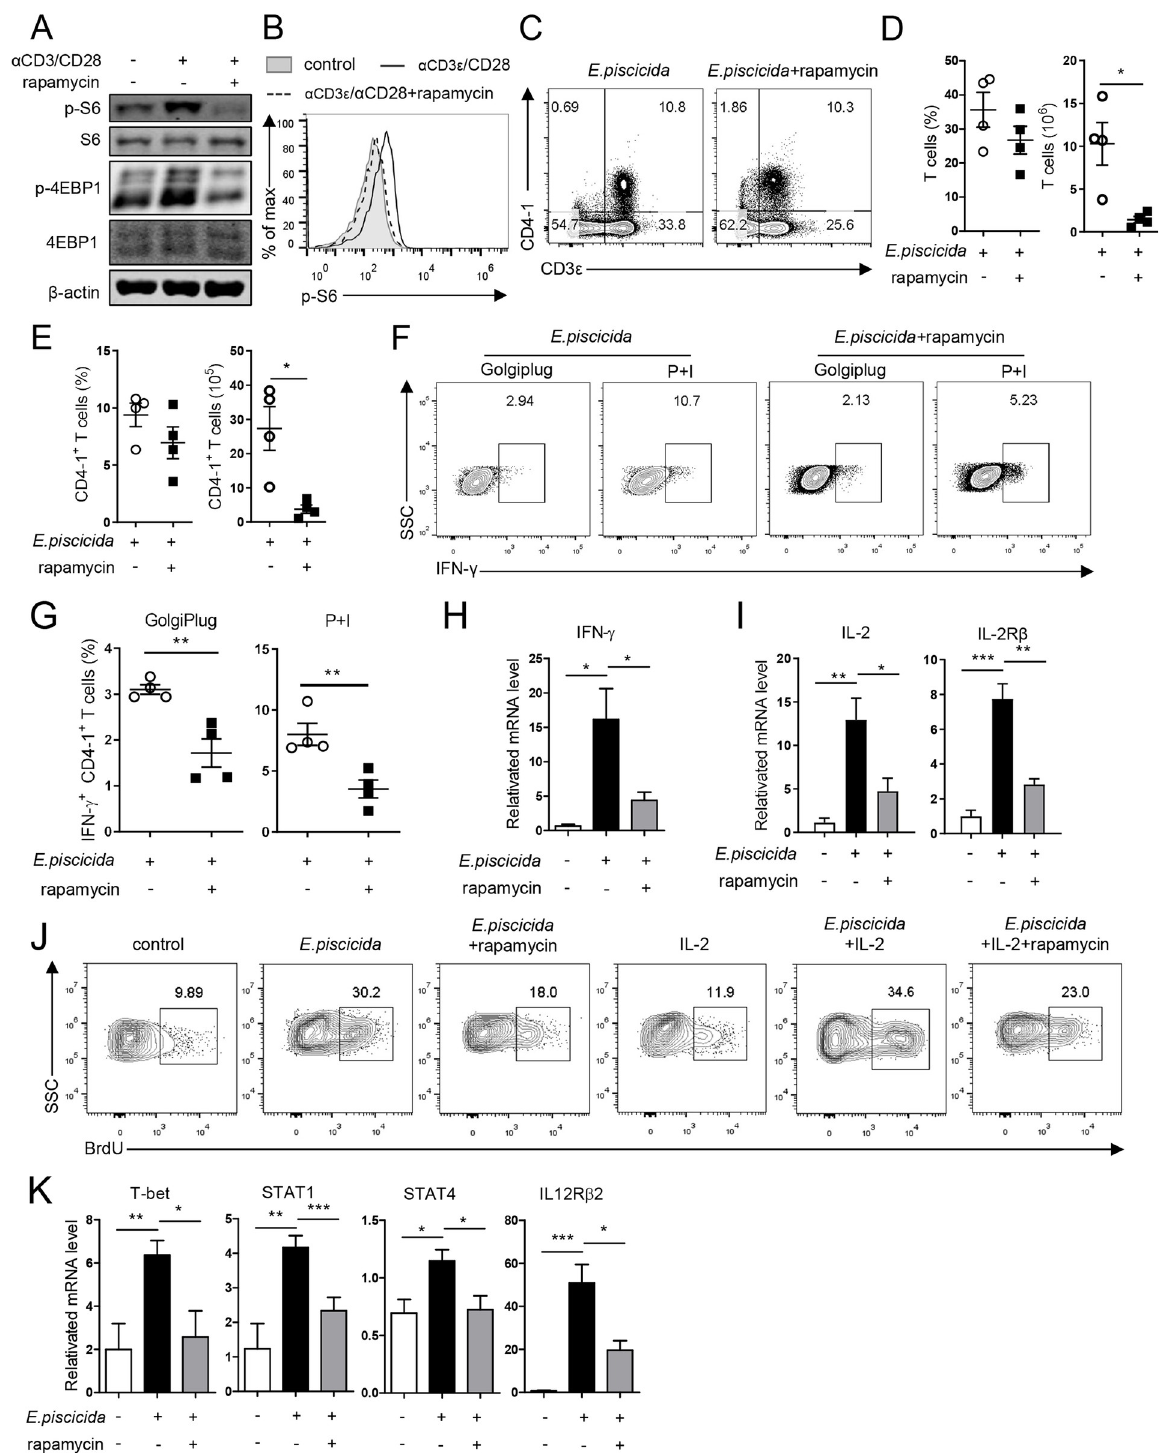
Fig 7. Tilapia requires mTORC1 signaling for Th1 cell development during E . piscicida infection. (A, B) Spleen leukocytes from rapamycin treated or untreated tilapia were stimulated with CD3 ε /CD28 mAbs for 12 h. ( A ) Western blot assay showed protein or phosphorylation levels of S6 and 4EBP1 in spleen leukocytes. ( B ) Overlaid histograms showed the phosphorylation levels of S6 in CD4-1 + T cells. ( C-K ) Tilapia individuals that infected with E . piscicida were treated with rapamycin or PBS. ( C ) Flow cytometry showed the spleen leukocytes stained with CD4-1 and CD3 ε mAbs on 7 DPI. ( D ) Scatter plot figures showed the percentage and absolute numbers of T cells, n = 4. ( E ) Scatter plot figures showed the